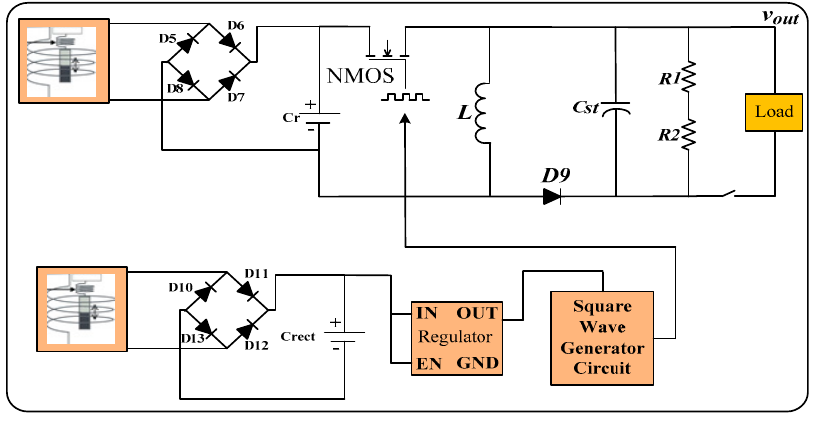
Figure 18. Power management circuit of electromagnetic energy harvester [28].